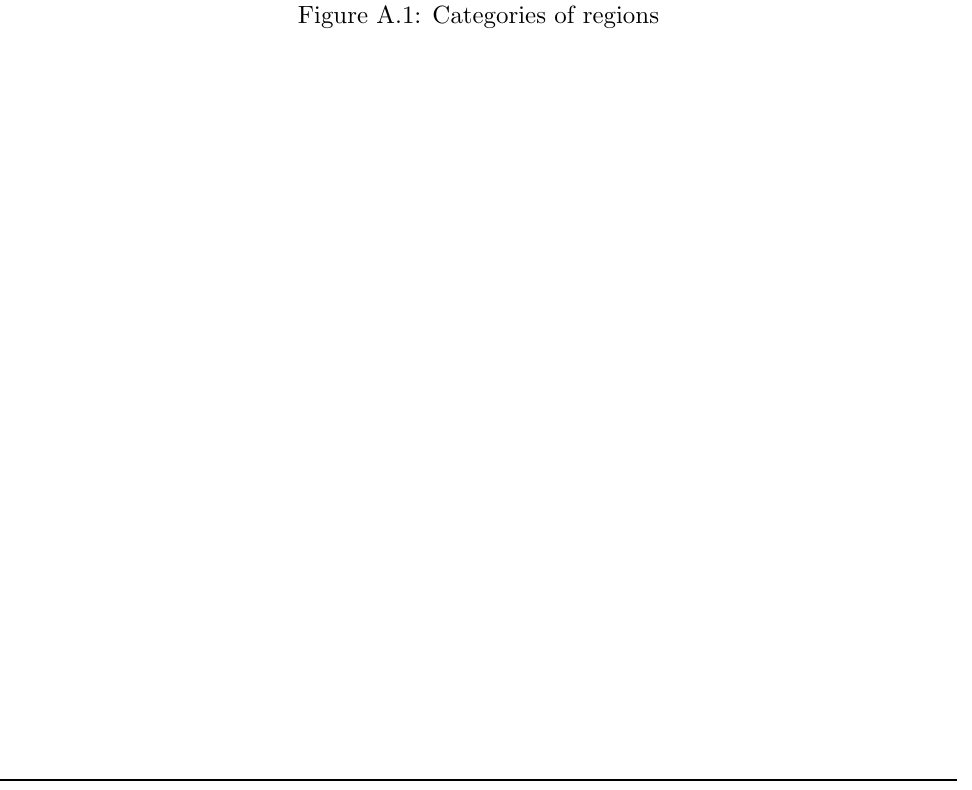
REGION : Volume 2, Number 2,